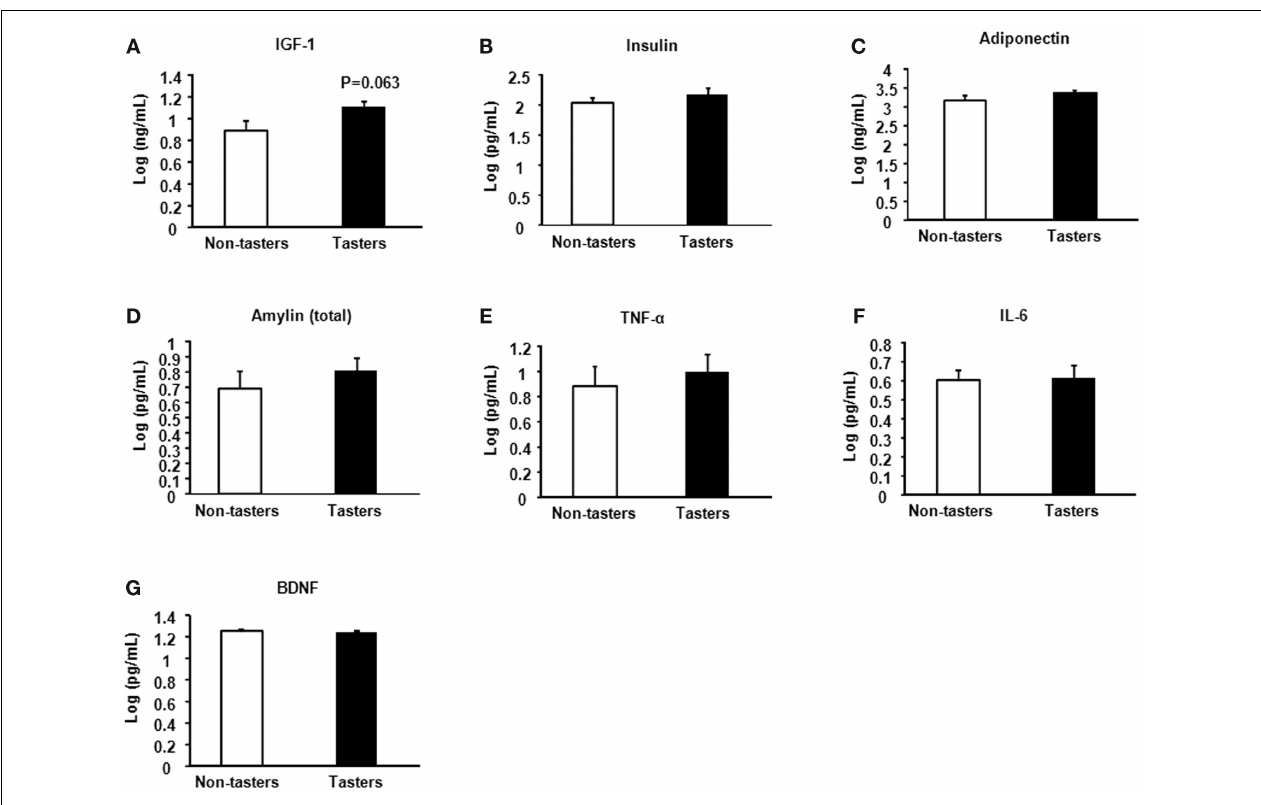
FIGURE 4 | Saliva hormones and cytokines of non-tasters and tasters . Saliva samples from non-tasters and tasters were assayed to measure the levels of IGF-1 (A) , insulin (B) , adiponectin (C) , amylin (D) ,TNF- α (E) , IL-6